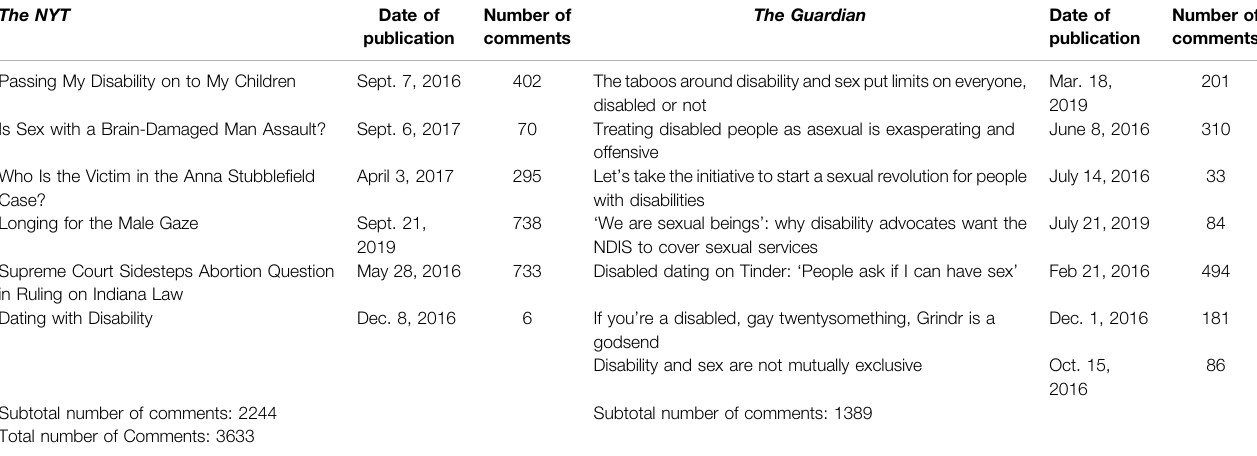
TABLE 1 | Summary of news article and opinion/editorial comments for